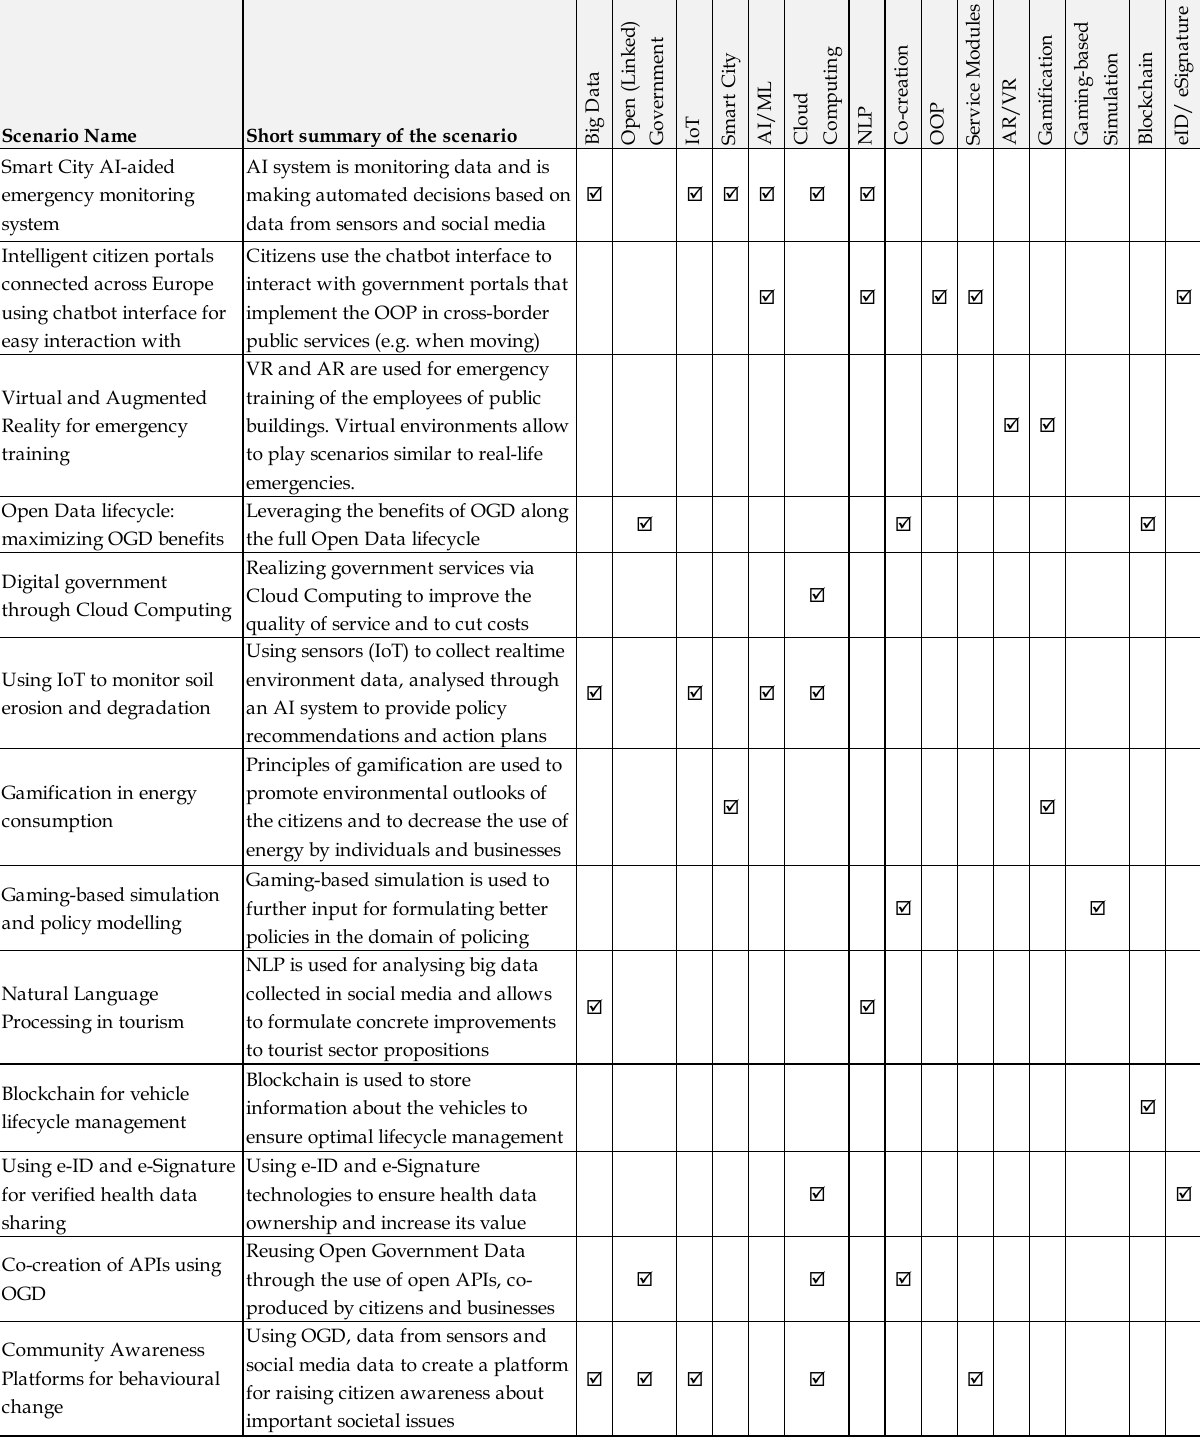
Table 1 for an overview of the scenarios developed, including the disruptive technologies embodied in each scenario). To exemplify the scenario technique, subsection 3.2 outlines the scenario "Virtual Reality and Augmented Reality for emergency training". Table 1. Scenarios developed and used for the analysis, including indications of technologies embodied